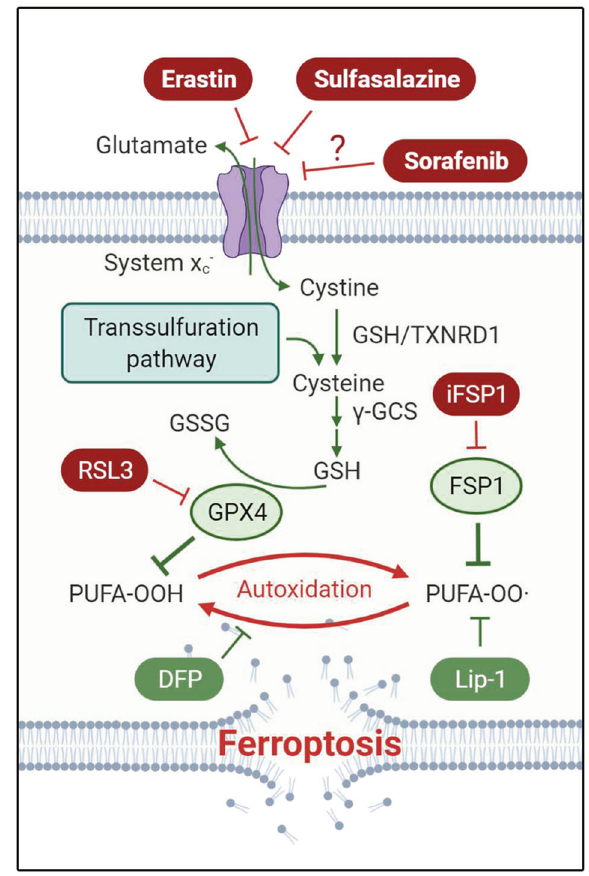
Fig. 1 Schematic representation of the key mechanisms involved in ferroptosis control. Cell death via ferroptosis is executed by iron-dependent lipid peroxidation occurring on polyunsaturated fatty acid (PUFA)-enriched phospholipids. This process can be prevented by iron chelators like deferiprone (DFP) and radical- trapping antioxidants like liproxstatin-1 (Lip-1). Glutathione peroxidase 4 (GPX4) and ferroptosis suppressor protein 1 (FSP1) are the main systems to counteract lipid peroxidation and ferroptosis. Inhibition of GPX4 by (1S,3R) -RSL3 (RSL3) and FSP1 by iFSP1, respectively, sensitizes cells to ferroptosis. Full activity of GPX4 requires suf fi cient glutathione (GSH/GSSG), whereby the synthesis of GSH relies on its rate-limiting substrate cysteine